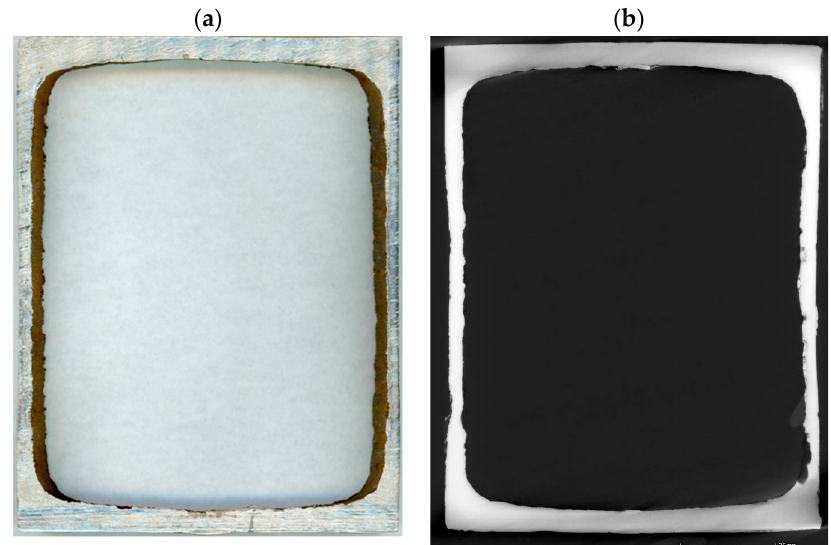
Figure 3. Guide cross section ( a ) and CT scan ( b ).